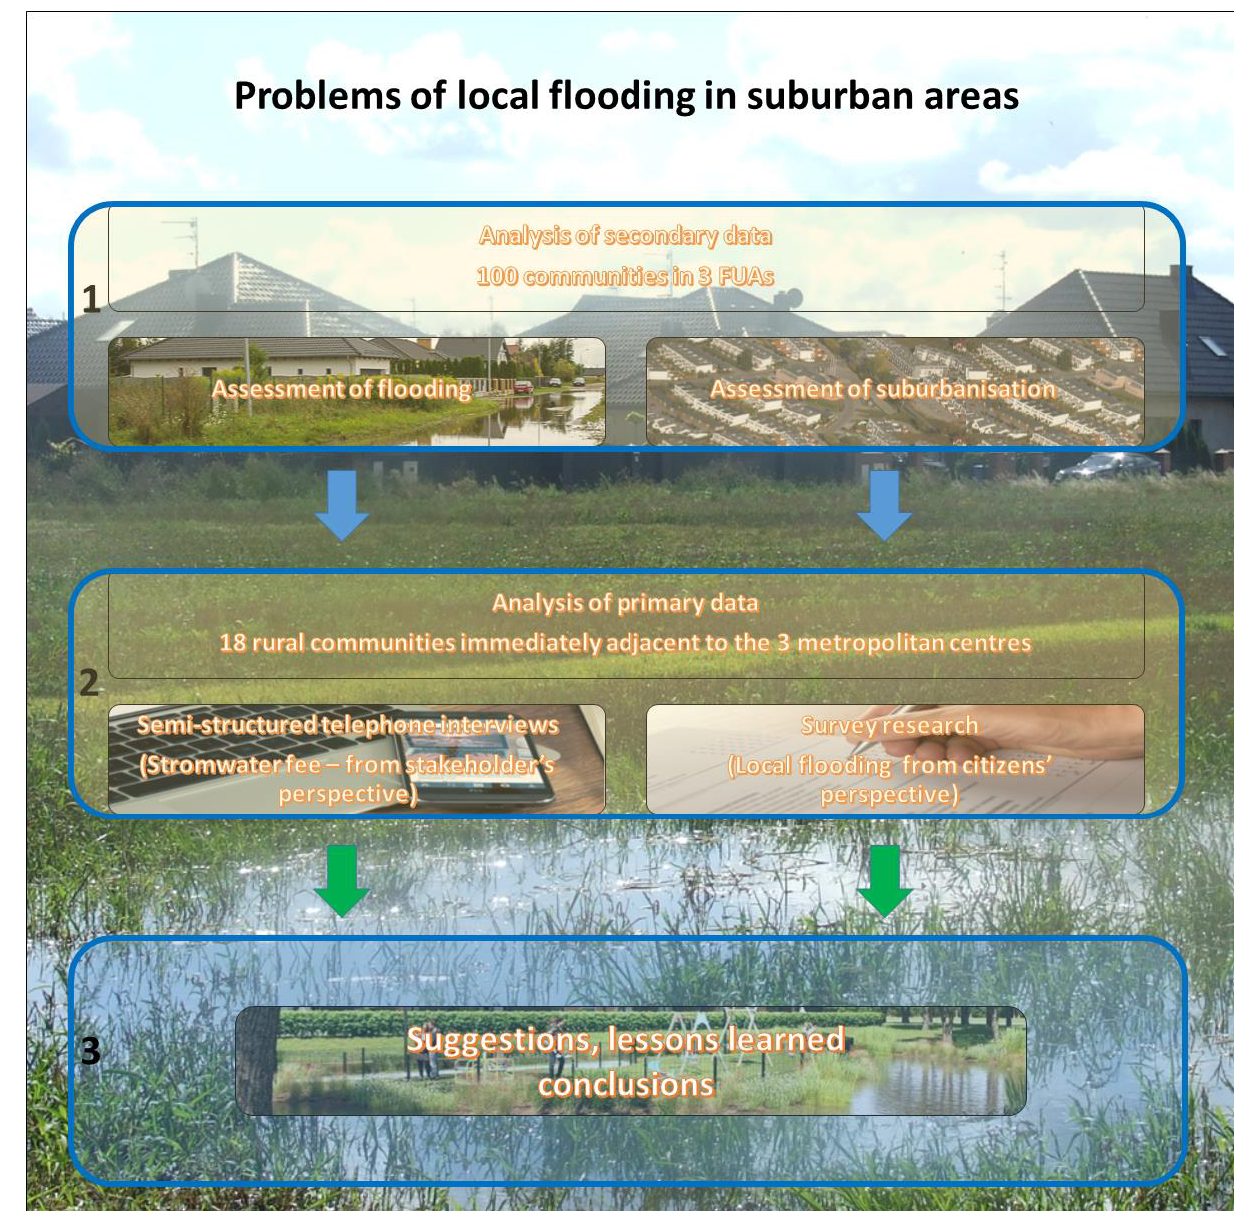
Figure 1. Flow chart of developing recommendations for rural communities directly adjacent to metropolitan cities in the field of local flooding protection.